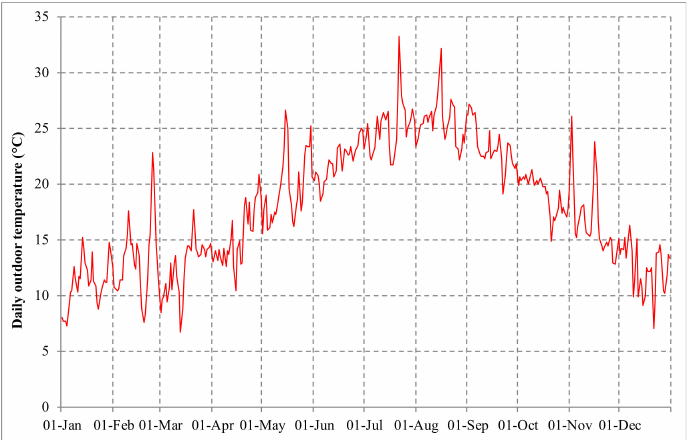
Figure 2. Trend of the outdoor air temperature during the monitoring